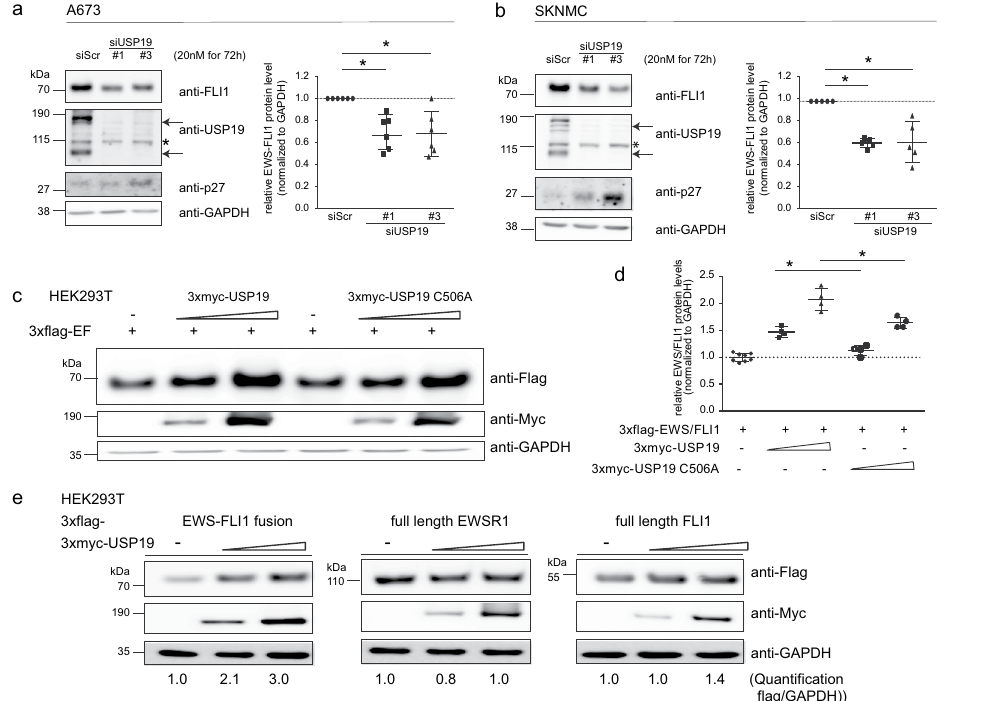
Figure 2. USP19 specifically modulates EWS-FLI1 protein levels. ( a , b ) Immunoblot analysis of USP19 depleted cells. ( a , b ) A673 and SKNMC cells were transiently transfected with 20 nM siRNAs for 72 h as indicated. Lysates were subjected to western blot analysis and analyzed by anti-FLI1, anti-USP19 and anti-p27 antibodies. Arrows indicate specific USP19 isoforms, asterisk marks an unspecific band. Right panel to each western blot, quantification of EWS-FLI1 proteins levels (n = 5–6, the mean is indicated by the horizontal line, error bars as SD). ( c ) Active USP19 stabilizes EWS-FLI1 protein. 3xflag-EWS-FLI1 was transiently co-expressed with a control vector or increasing levels (ratios 3xflag-EWS-FLI1 to 3xmyc-USP19 1:2 and 1:4) of wild-type or catalytically inactive 3xmyc-USP19 for 48 h in HEK293T cells. Lysates were analyzed by western blotting using anti-flag and anti-myc antibodies. ( d ) Quantification of 3xflag-EWS-FLI1 protein levels of ( c ) with n = 8 for control and n = 4 for others, the mean is indicated by the horizontal line and error bars as SD. ( e ) USP19 overexpression stabilizes specifically EWS-FLI1. 3xflag-EWS-FLI1, 3xflag-EWSR1 and 3xflag-FLI1 were transiently co-expressed with increasing concentrations (ratios 3xflag-protein to 3xmyc-USP19 1:2 and 1:4) of active 3xmyc-USP19 for 48 h in HEK293T cells. Lysates were analyzed by western blotting using anti-flag and anti-myc antibodies. Numbers below represent densitometrically quantified flag tagged protein over loading control GAPDH of a representative